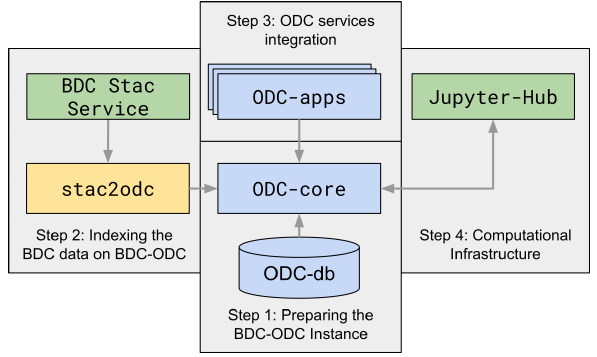
Figure 2. Overview of data flow from BDC data to the BDC-ODC